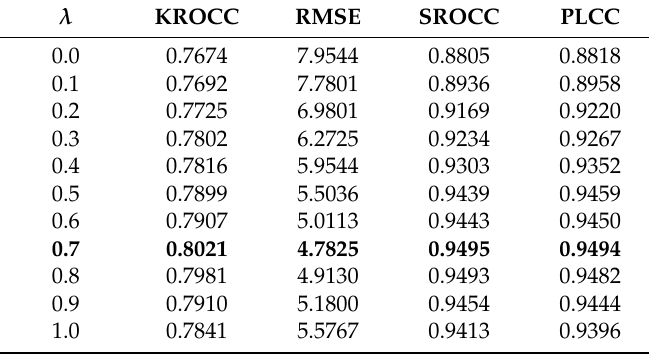
Table 1. Performance of ROI-BRISQUE which ROI extracted by the improved Itti model. The numbers in bold are the best